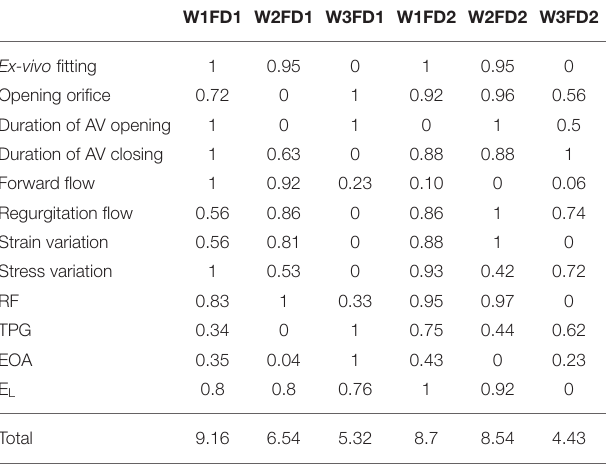
TABLE 8 | Comparison of simulated results with scaled